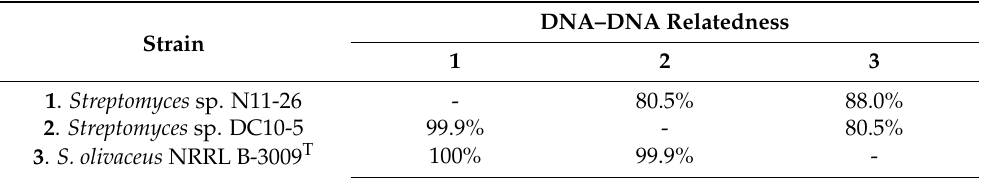
Table 2. DNA–DNA relatedness and 16S rRNA gene similarities among Streptomyces sp. N11-26 (1),